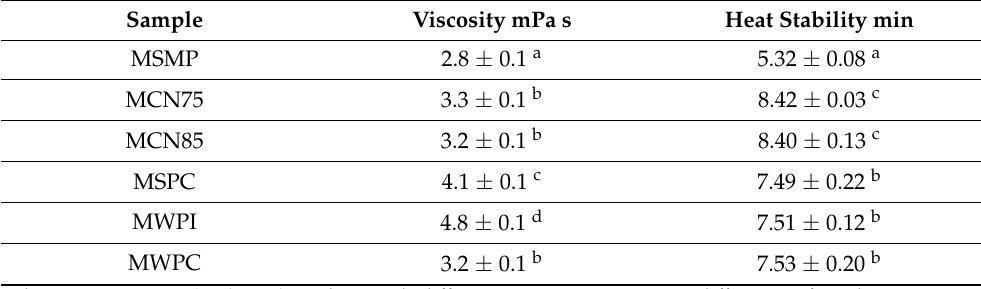
Table 4. Viscosity and heat stability of non-fermented milks enriched with protein preparations.